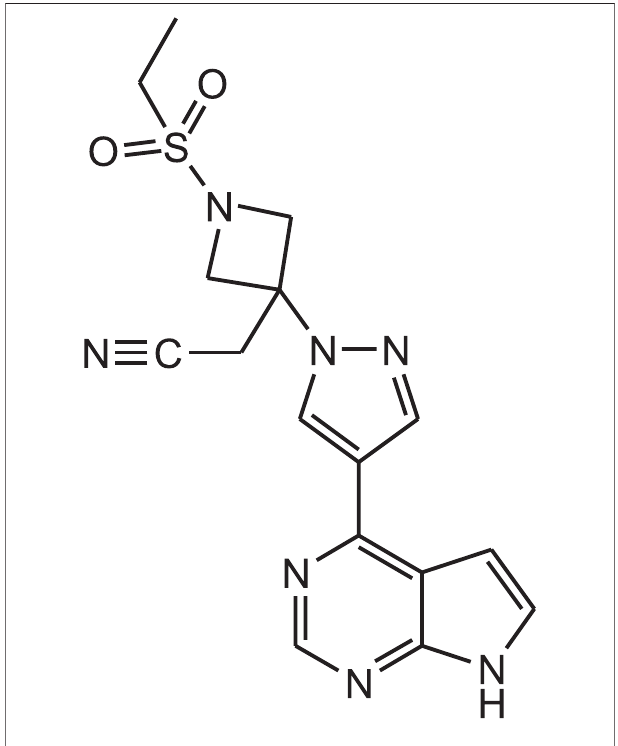
FIGURE 3 | Structure of